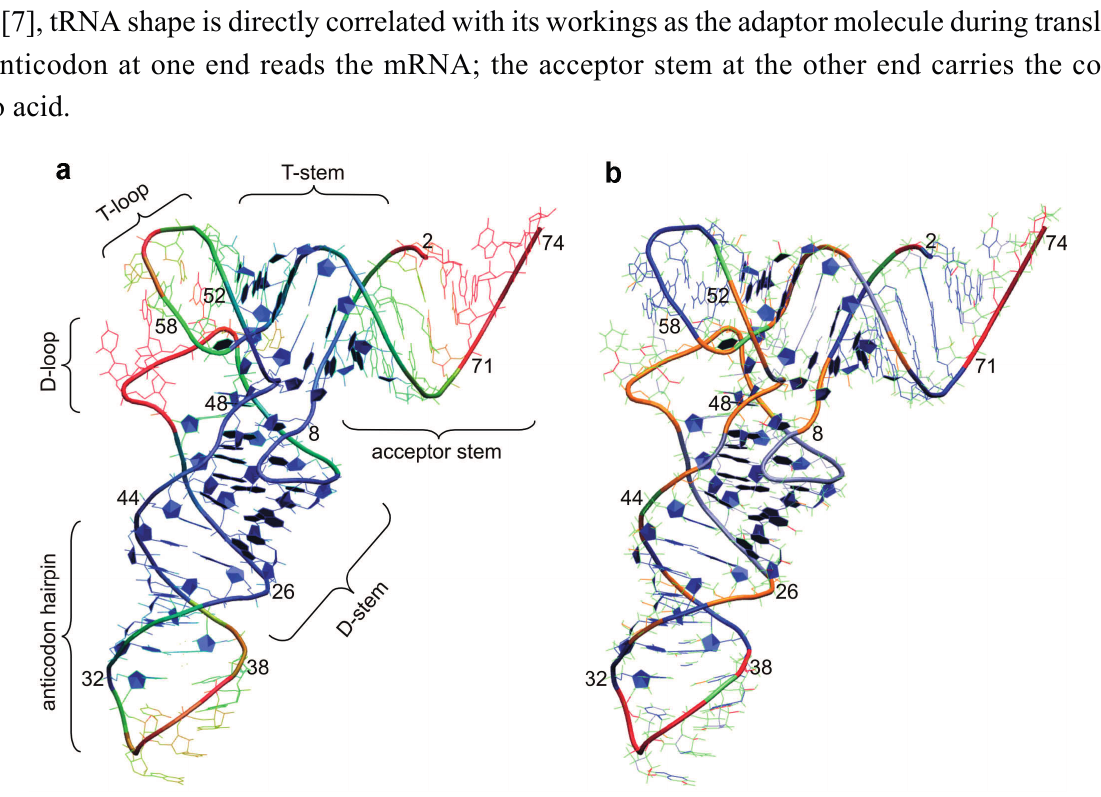
Figure 1. Tertiary structure and computational analysis of tRNA’s structural plasticity. ( a ) Color-coded B factor information, which can be described as flexibility estimation, is displayed for the phosphorus atoms of tRNA Asp X-ray structure (PDB 2TRA) [8]; ( b ) Color-coded flexibility prediction by constraint counting for the same tRNA species, in which overconstrained regions are indicated in blue, rigid regions in green, and flexible regions in red. (Figure adapted from [9], Copyright 2008